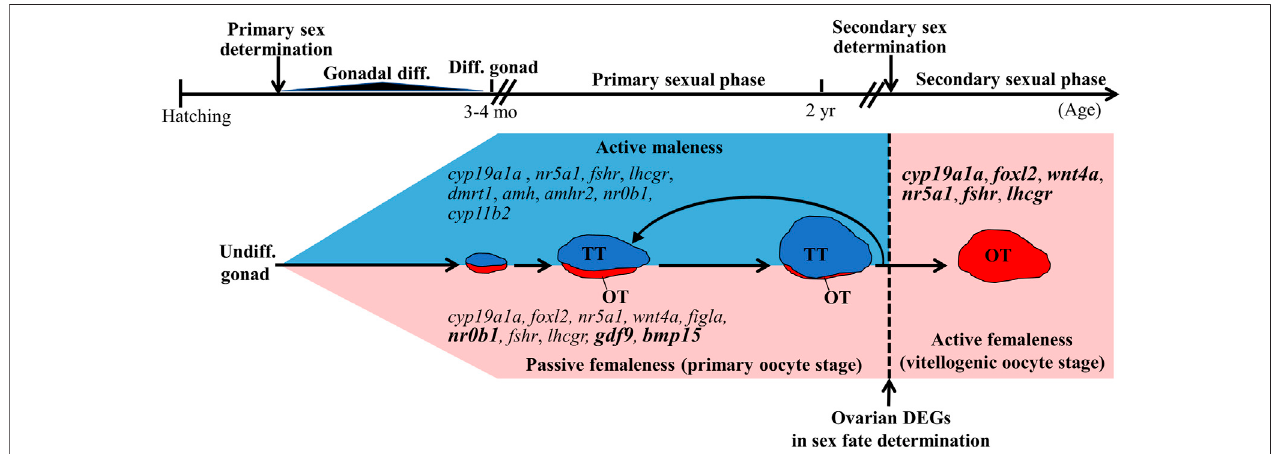
FIGURE 9 | Summary of sex-related genes involved in sex determination, differentiation, and development in black porgy. Primary sex determination and gonadal differentiation occurred around 3 – 4 months after hatching. But the exact timing and genes of primary sex determination are still not clear. The fi sh has functional males during the fi rst two reproductive cycles. After secondary sex determination, we can observe developing ovaries with rudimentary testis. However, the key factors that activate secondary sex determination are still not clear. DEGs (differentially expressed genes) found in this study may be a potential secondary sex determination gene. Bold letters in the pink area indicate the genes have signi fi cantly higher expressions in the ovarian tissue with primary oocyte stage compared with vitellogenic oocyte stage. Genesinthe pinkarea indicate that thegenes expressed at high levels in theovary.Genes inthe blue areaindicate that thegenes expressed at high levels in the testis. Undiff. gonad, undifferentiated gonad; Diff. gonad, differentiated gonad; Gonadal diff., Gonadal